Question: Author a descriptive caption for the visualization shown.
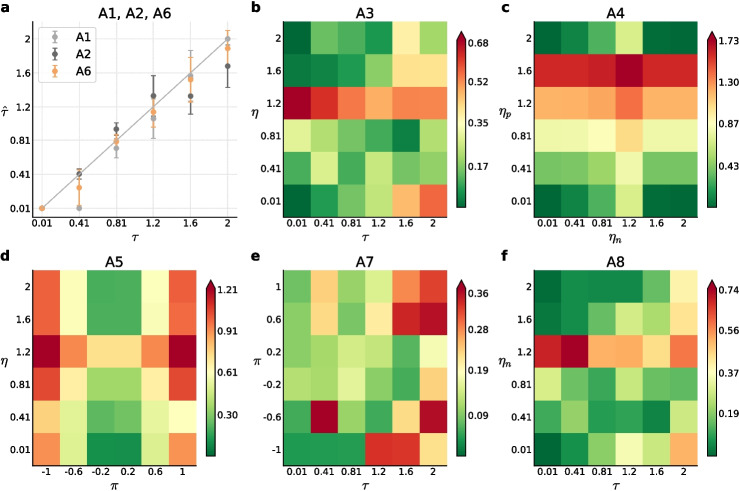
Answer: Parameter recovery results for all agents with free parameters. a The panel shows the ML estimates \documentclass[12pt]{minimal} \usepackage{amsmath} \usepackage{wasysym} \usepackage{amsfonts} \usepackage{amssymb} \usepackage{amsbsy} \usepackage{mathrsfs} \usepackage{upgreek} \setlength{\oddsidemargin}{-69pt} \begin{document}$$\hat{\tau }$$\end{document} τ ^ as a function of the data-generating post-decision noise parameter \documentclass[12pt]{minimal} \usepackage{amsmath} \usepackage{wasysym} \usepackage{amsfonts} \usepackage{amssymb} \usepackage{amsbsy} \usepackage{mathrsfs} \usepackage{upgreek} \setlength{\oddsidemargin}{-69pt} \begin{document}$$\tau $$\end{document} τ . Agents A1, A2, and A6 are differentiated in terms of the colors (light gray, dark gray, orange). The diagonal line corresponds to perfect parameter estimation. Markers represent average ML estimates and whiskers refer to SD s across the artificially generated data sets. b-f Colors encode the Euclidean distance between the average ML estimates and the true data-generating parameter values. All parameter values were rounded to two decimal places. For the generation of this figure, please refer to abm_figure_8.py